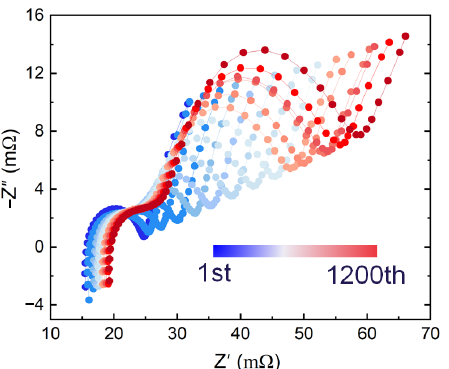
Figure 9. Evolution of the Nyquist plot (obtained through EIS measurements) due to aging from BOL to 1200 EFCs of an NMC ‐ based Li ‐ ion battery. Aging: WLTC discharging to 75% DOD and full re ‐ charging with 0.5 C ‐ rate at 45 °C. EIS measurement: 6.5 kHz–10 mHz frequency range, 50% SOC, and 25 °C.